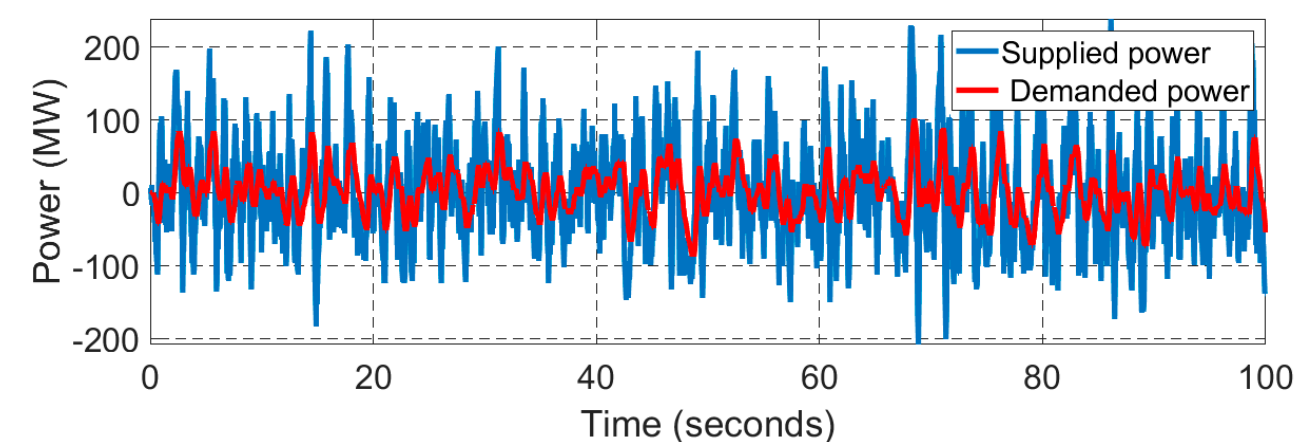
Figure 20. Step change load at an unbalance condition for a two-area PSN; ( a ) frequency, ( b ) power.